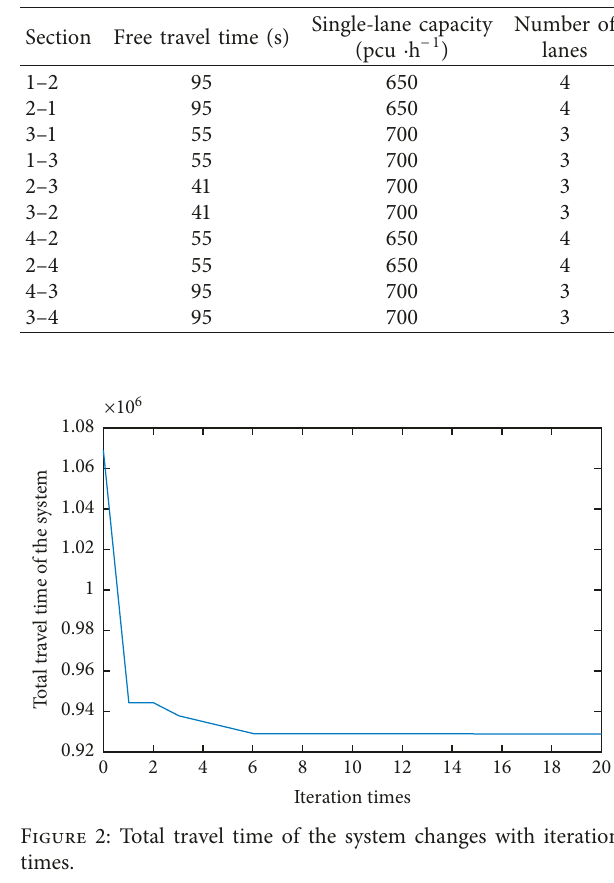
Figure 1: Test road network. Table 2: Characteristic parameters of each section.